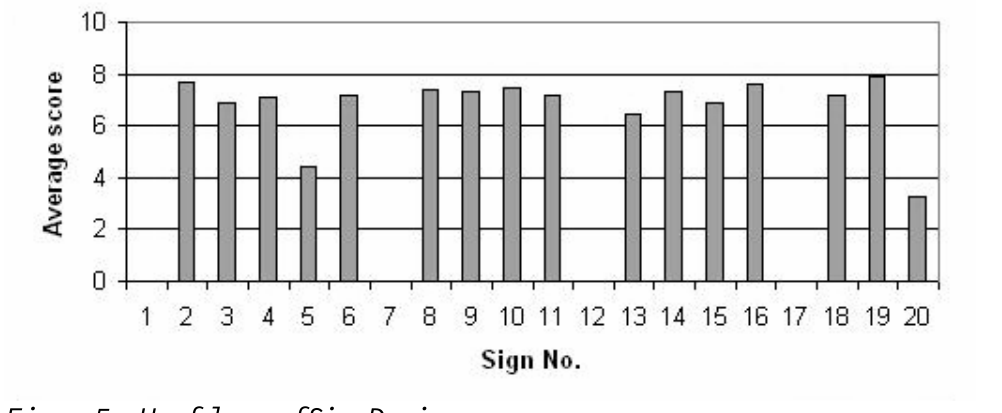
Figure 5a. Usefulness of Sign